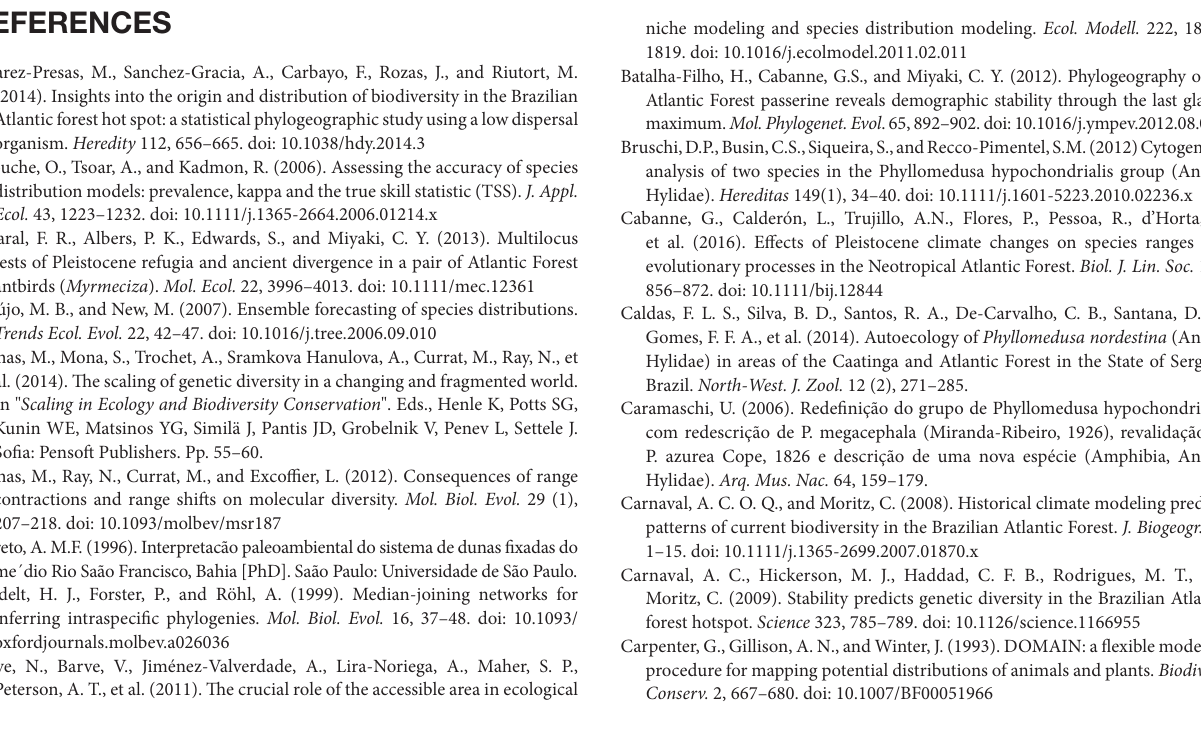
FIGURE S1 | Bayesian Analyses of Population Structure (BAPS) results. The colors represent the subdivisions indicated, and the mitochondrial results are shown in Figure 3. FIGURE S2 | Mitochondrial and nuclear tree obtained in *BEAST analysis. ( A ) 16S gene; ( B ) ND2; ( C ) SiaH; ( D ) Rhod. FIGURE S3 | Confusion matrix generated by the cross-validation performed using the “abc” package on R. FIGURE S4 | Goodness-of-fit PCA analysis of the summary statistics simulated under Model